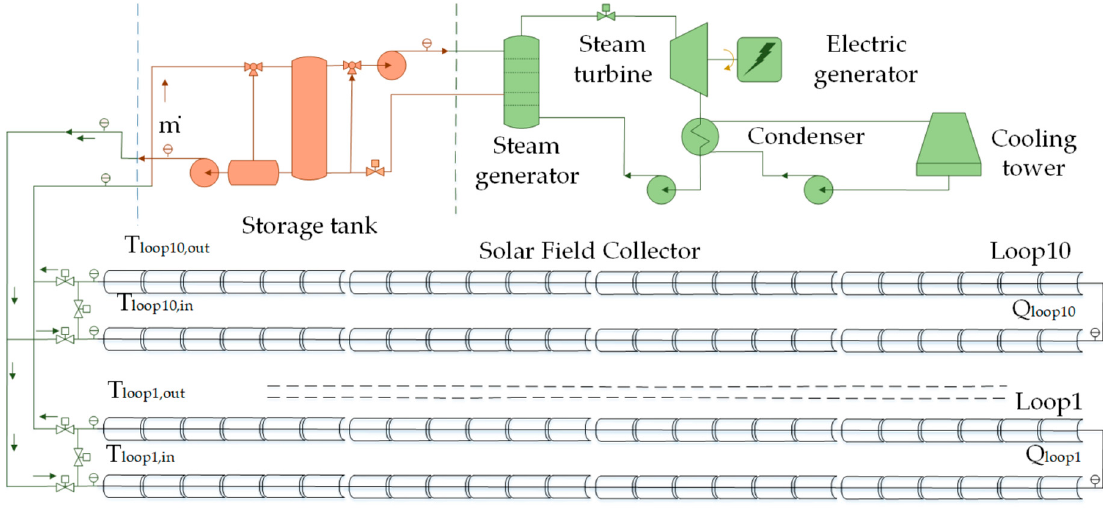
Figure 4. Proposed plant [21] .